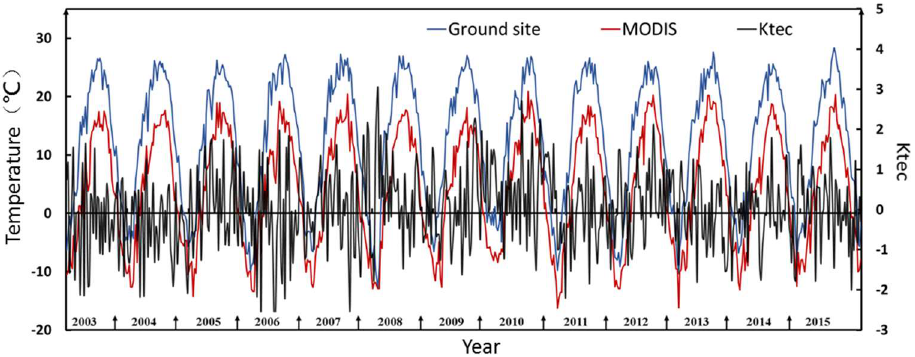
Figure 17. Comparison of the temperature between from MODIS LST data and air temperature acquired by the Yutian meteorological ground station, and TIR anomaly based on the TTIA algorithm. The blue line denotes the daytime air temperature data observed by the ground site, the red line denotes the MODIS LST data at night, and the black line denotes the TIR anomaly based on the TTIA algorithm.